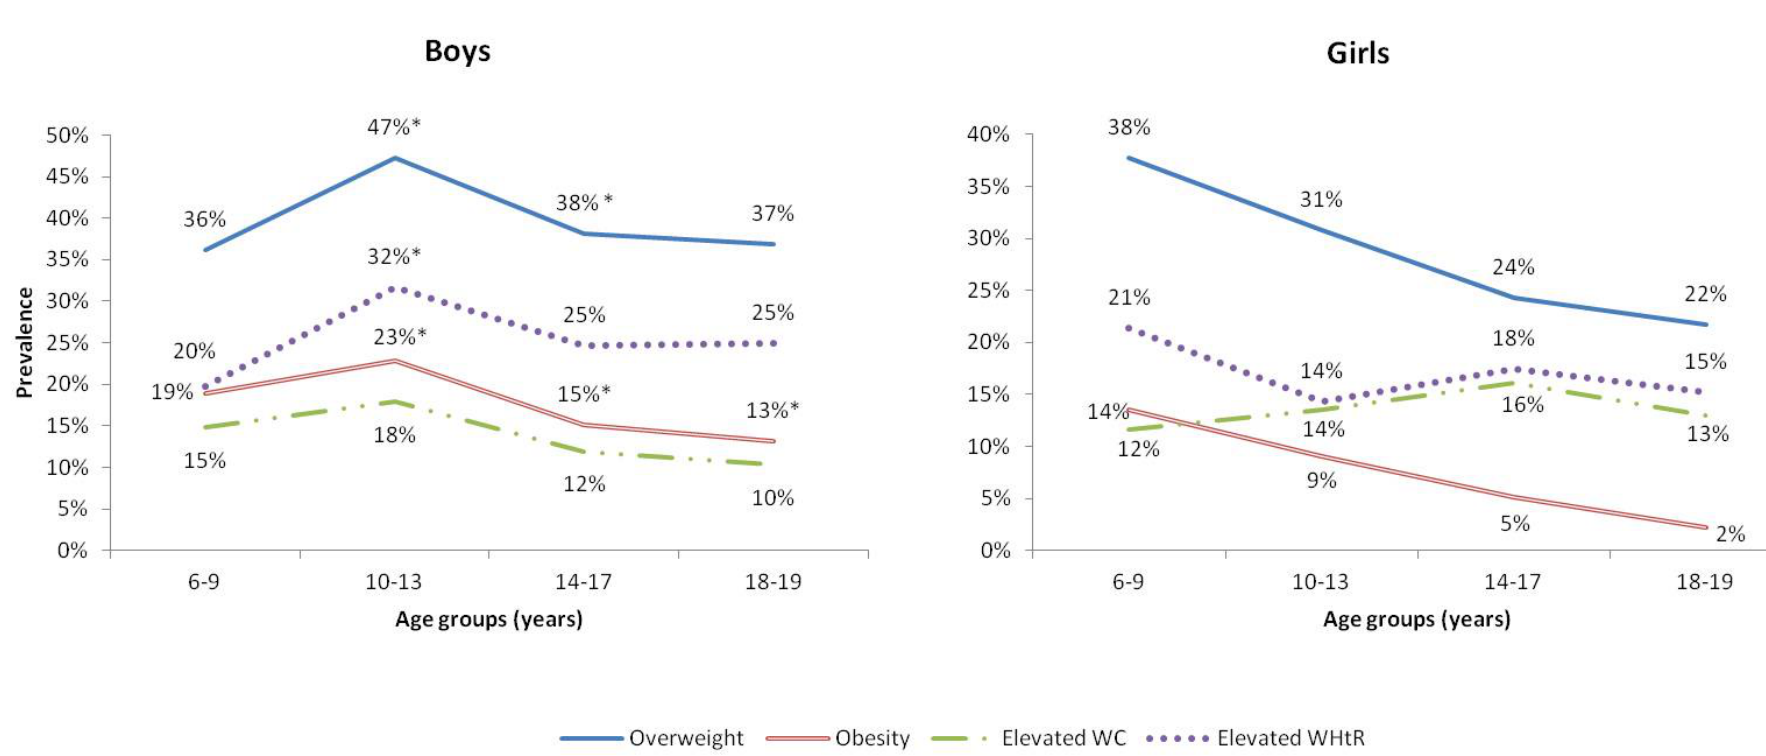
Figure 1. Prevalence of overweight, obesity, elevated WC and elevated WHtR amongst Lebanese children and adolescents ( n = 868) by age and gender (* Significant difference by gender p <